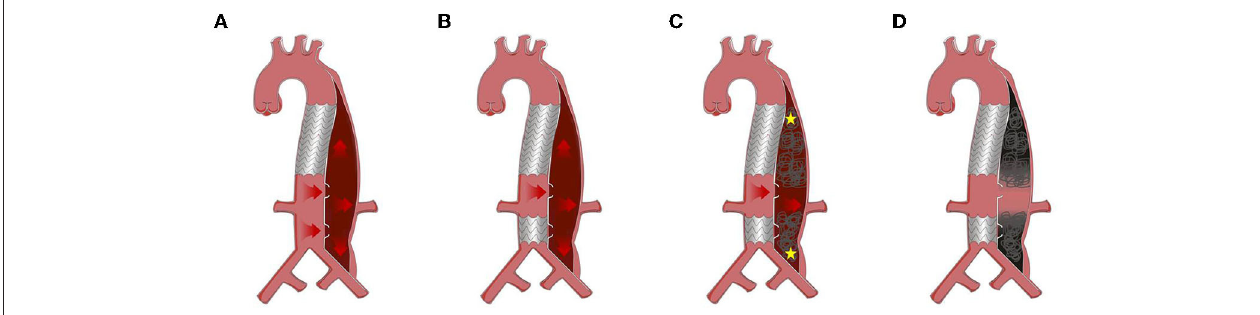
FIGURE 2 | Protocol of road block strategy (RBS). (A) Distal dilatation of chronic aortic dissection in the visceral part (CADAV), red arrow represents blood flow direction. (B) Excluding tears away from visceral artery with covered stent. (C) False lumen (FL) embolism with coils, Onyx glue, or occluders, from the proximal and